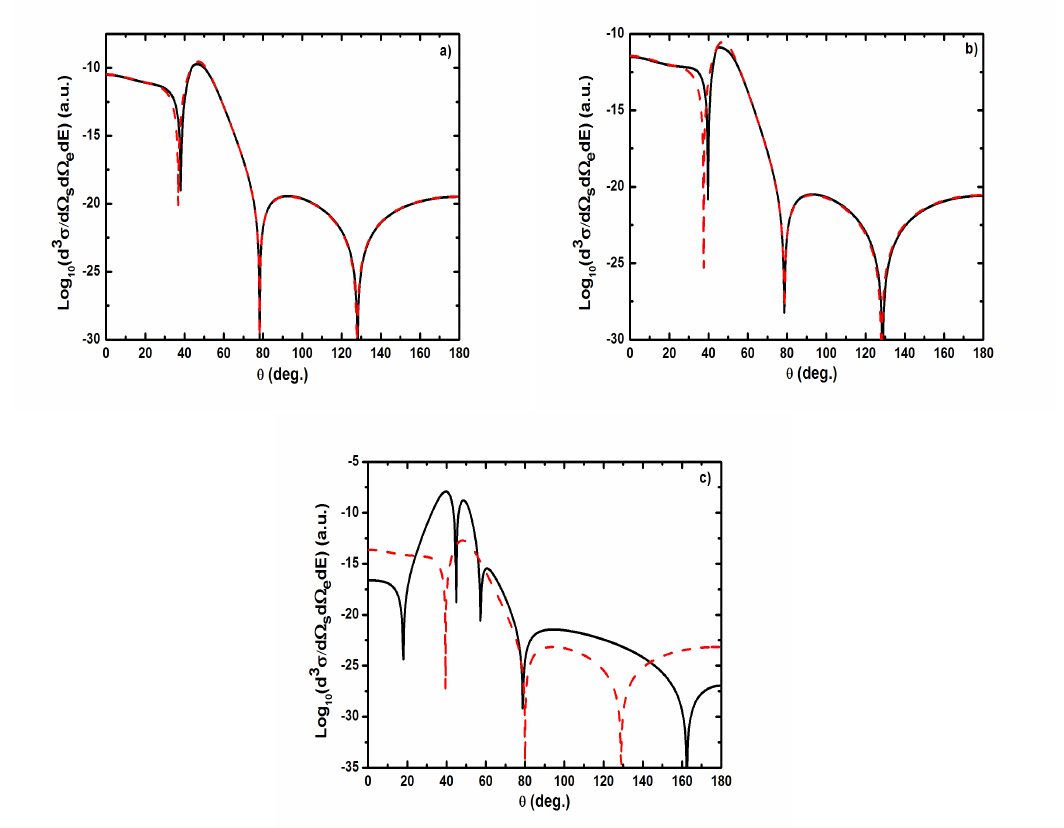
Figure 26. Triple differential cross sections corresponding to laser-assisted electron-impact ionization of atomic hydrogen in the ground state for the case of a coplanar symmetric geometry as a function of scattering angle θ = θ s = θ e for the absorption of one photon ( (cid:96) = 1). The incident electron energy is = 250 eV, and the electric field strength is kept fixed at E = 10 6 V/cm. The laser photon energy is E k 0 i ( a ) ω = 4.95 eV; ( b ) ω = 6.42 eV; ( c ) ω = 11.7 eV. The laser polarization vector is taken to be parallel to the incident momentum k i . Solid lines: First Born approximation results. Dashed line: results obtained by neglecting the dressing of the target by the laser